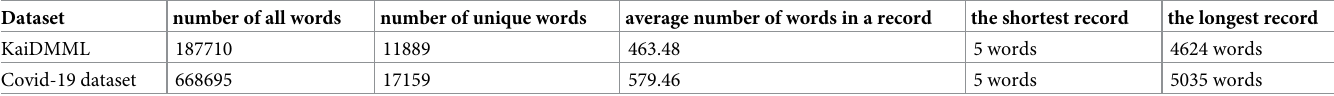
Table 2. Dataset